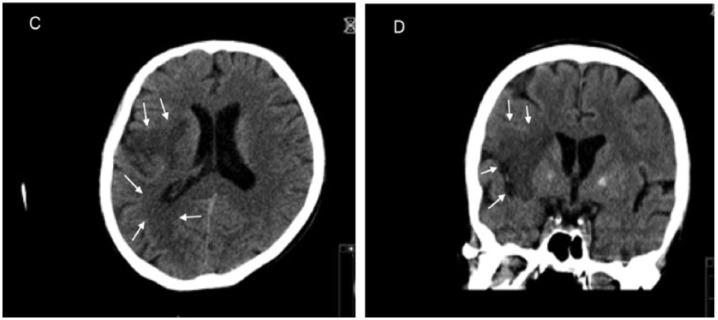
Computed tomography of the head—transverse plane (C) and frontal plane (D)—displaying hypodense areas (white arrows) consistent with subacute cerebral infarctions.